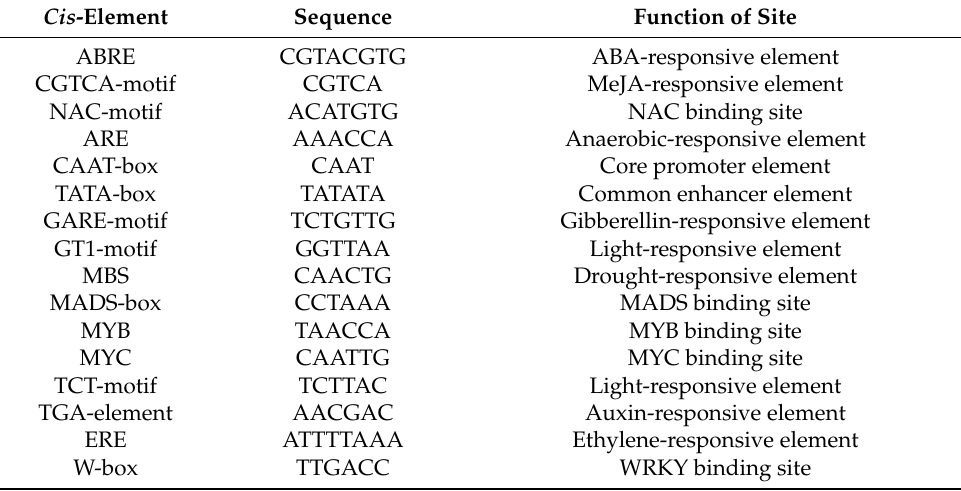
Table 1. The putative regulatory elements were identified in the CmLCYB promoter